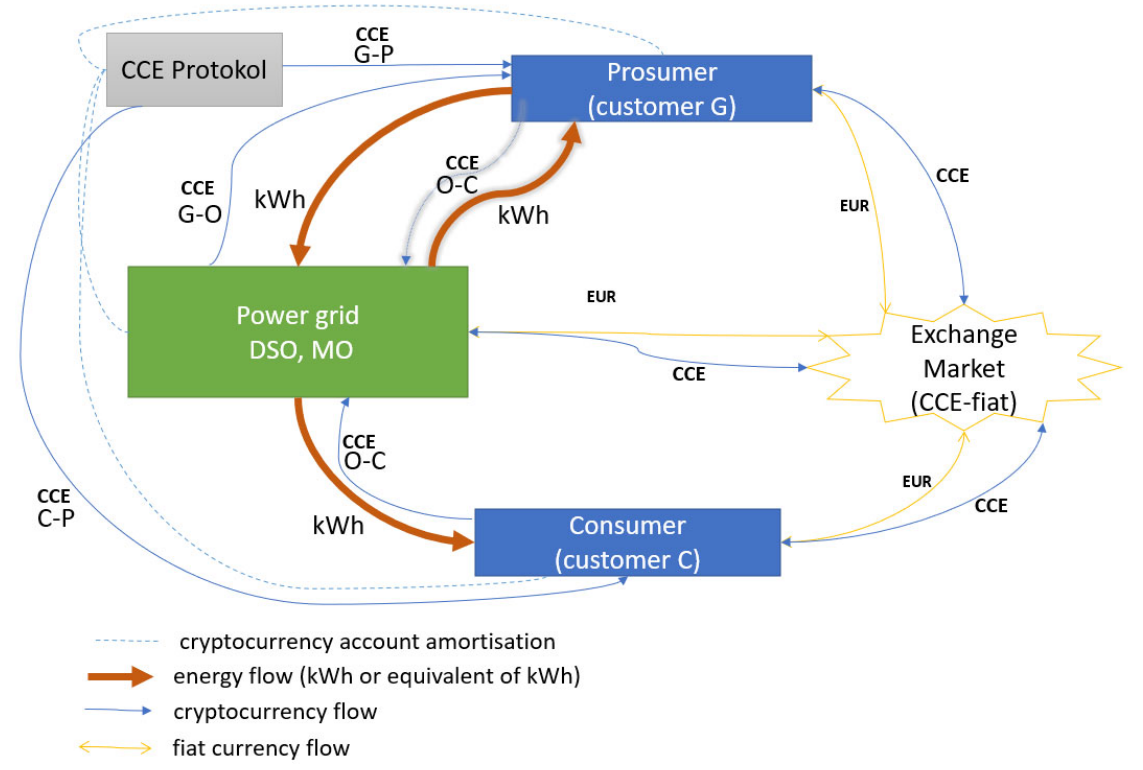
Figure 8. Functional diagram of the net billing CCE system.